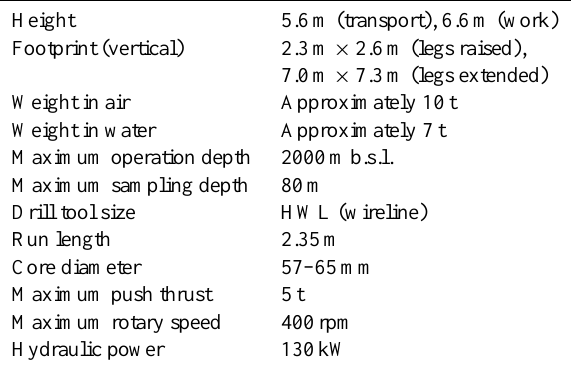
Table 1. Specification and capabilities of the